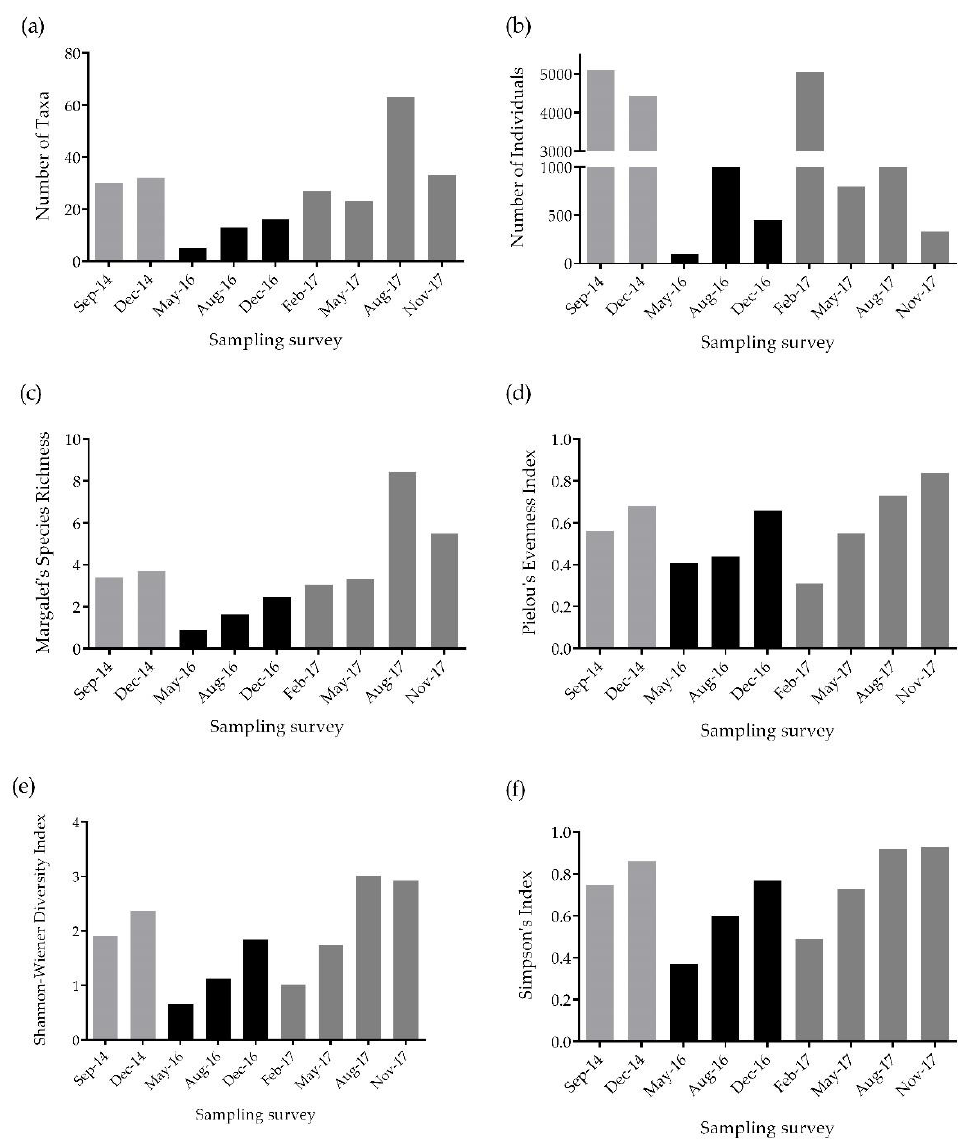
Figure 4. Comparison of the number of taxa ( a ), number of individuals ( b ), Margalef’s species richness ( c ), Pielou’s evenness index ( d ), Shannon–Wiener diversity ( e ) and Simpson’s index ( f ) of aquatic invertebrates collected during the sampling surveys in 2014 (predrought), 2016 (drought) and 2017 (recovery) in Lake Nyamithi.